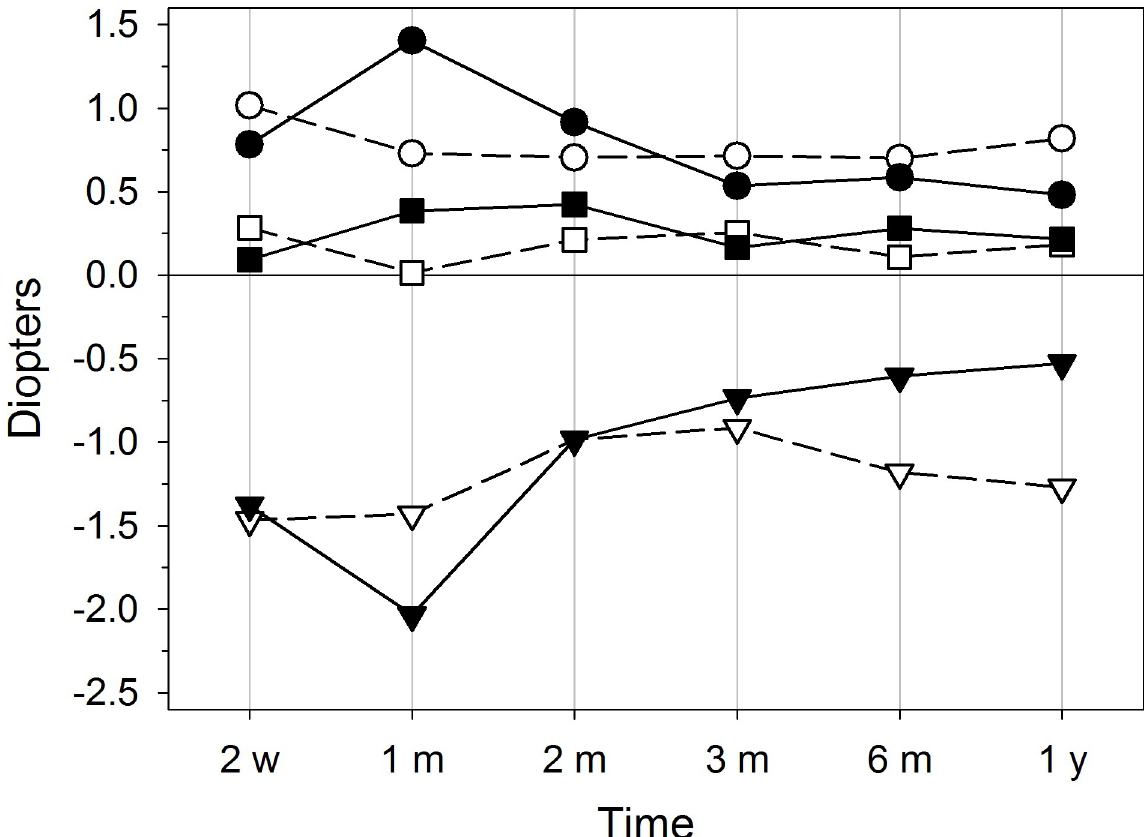
Fig 3. Temporal evolution of induced refraction components of the cornea: sphere (circles), cylinder (triangles) and spherical equivalent (squares), in two right eyes of different patients: S1 (black symbols) and S2 (white symbols).